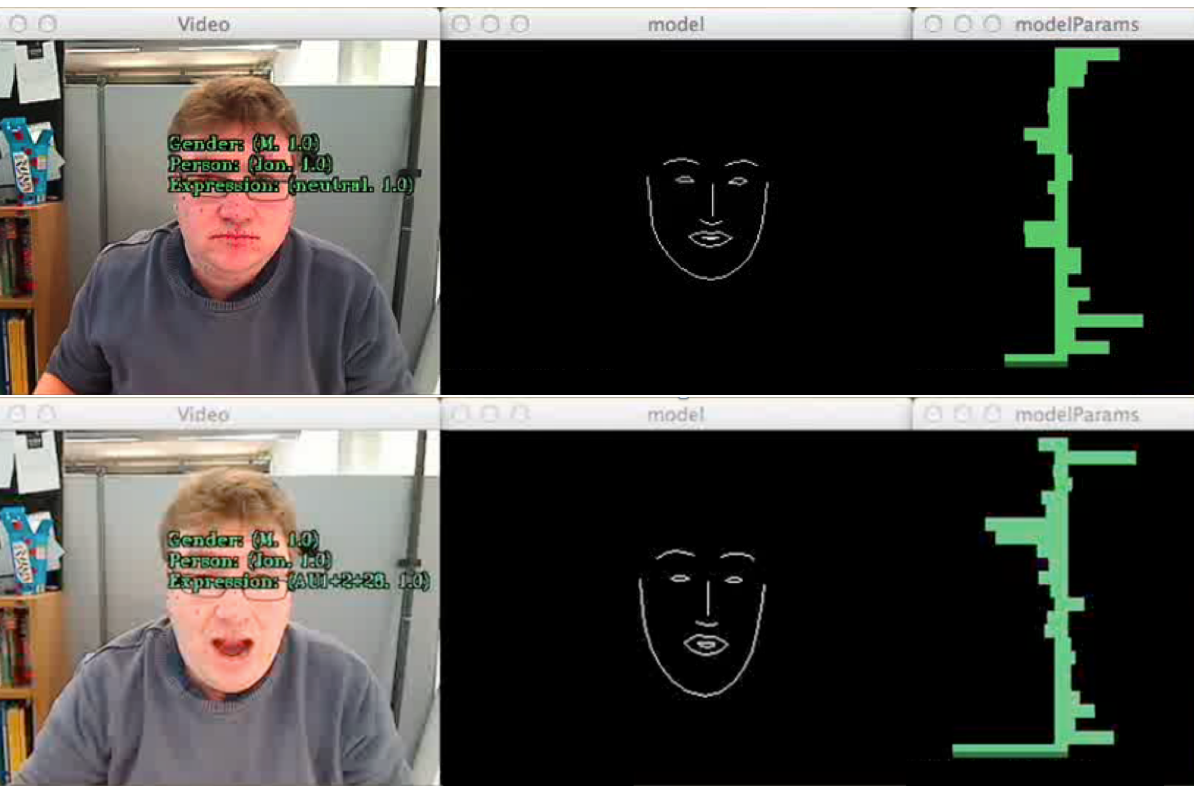
Figure 7. Screenshots of our experimental expression recognition system. The left window shows the input from a video camera, with live predictions of the name and gender of the subject(s), together with predictions of facial action units. The middle image shows the reconstructed shape model, and the third window shows the shape parameters of the model as a bar